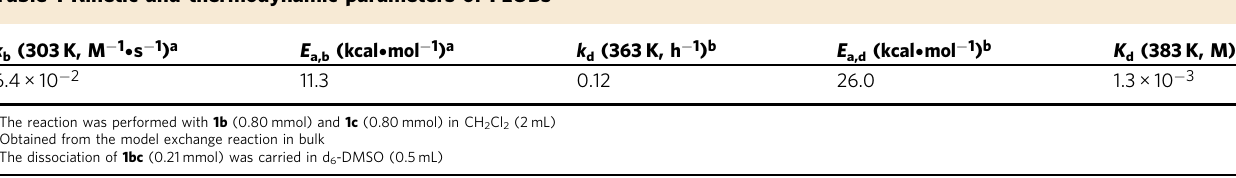
Table 1 Kinetic and thermodynamic parameters of